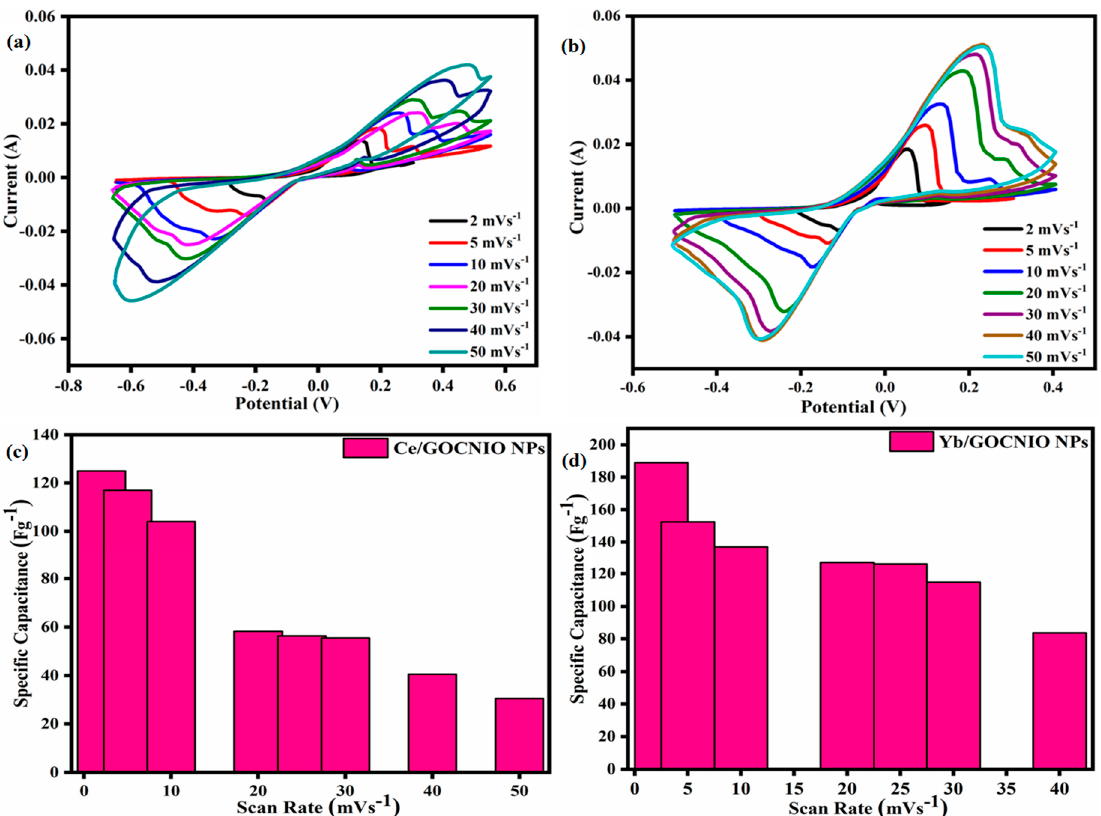
Figure 4. ( a ) CV Profile of Ce/GOCNIO NPs; ( b ) CV Profile of Yb/GOCNIO NPs; ( c ) Influence of scan rates on specific capacitance of Ce/GOCNIO NPs; and ( d ) Influence of scan rates on specific capacitance of Yb/GOCNIO NPs.